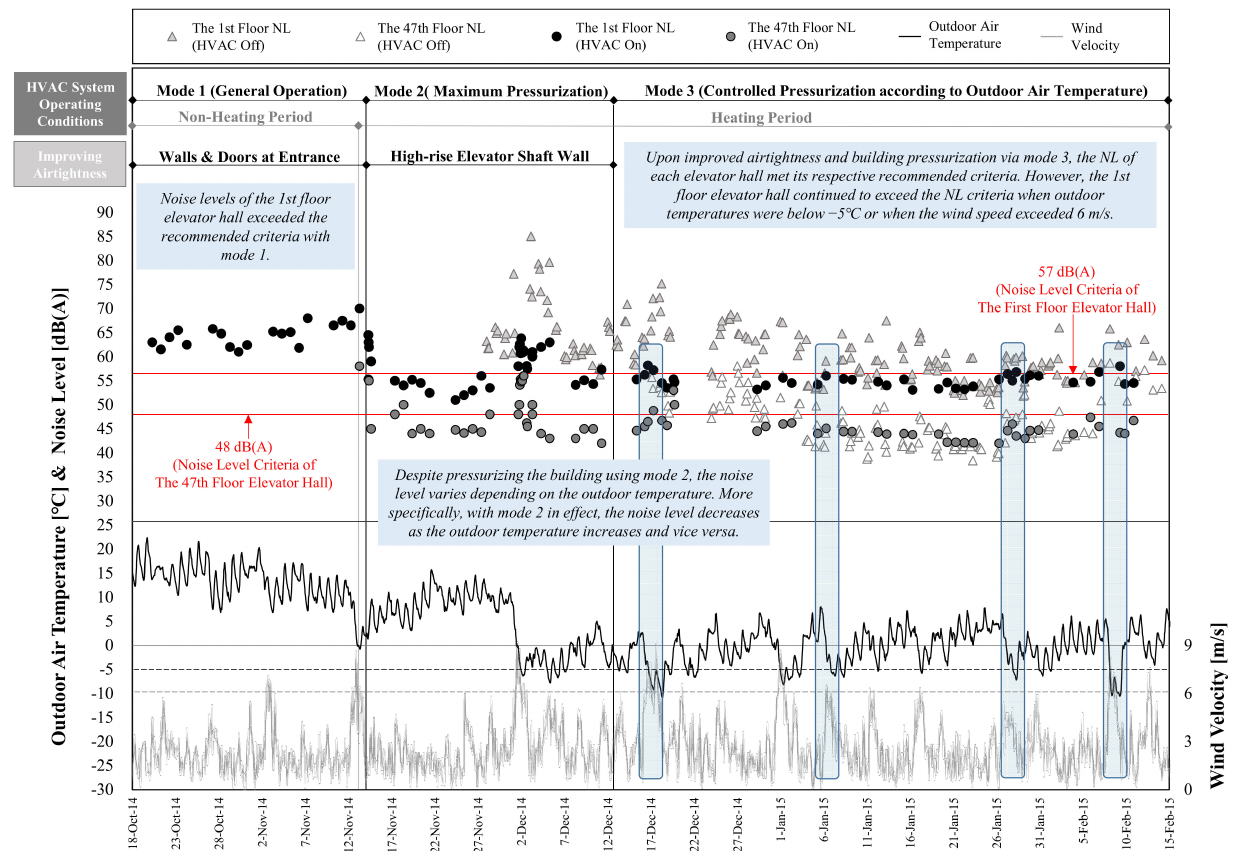
Figure 8. Noise distribution on 1st- and 47th-floor elevator halls (Winter 2014). The distribution of NL with and without HVAC pressurization is shown, and improvements in the pressurization method to resolve the problem are shown as a function of the outdoor temperature. The wind speed distribution was also checked, and the resulting NL change was also reviewed. Here, the recommended NL criteria for the elevator hall for the 1st floor were 57 dB(A) and 48 dB (A) for the 47th-floor elevator